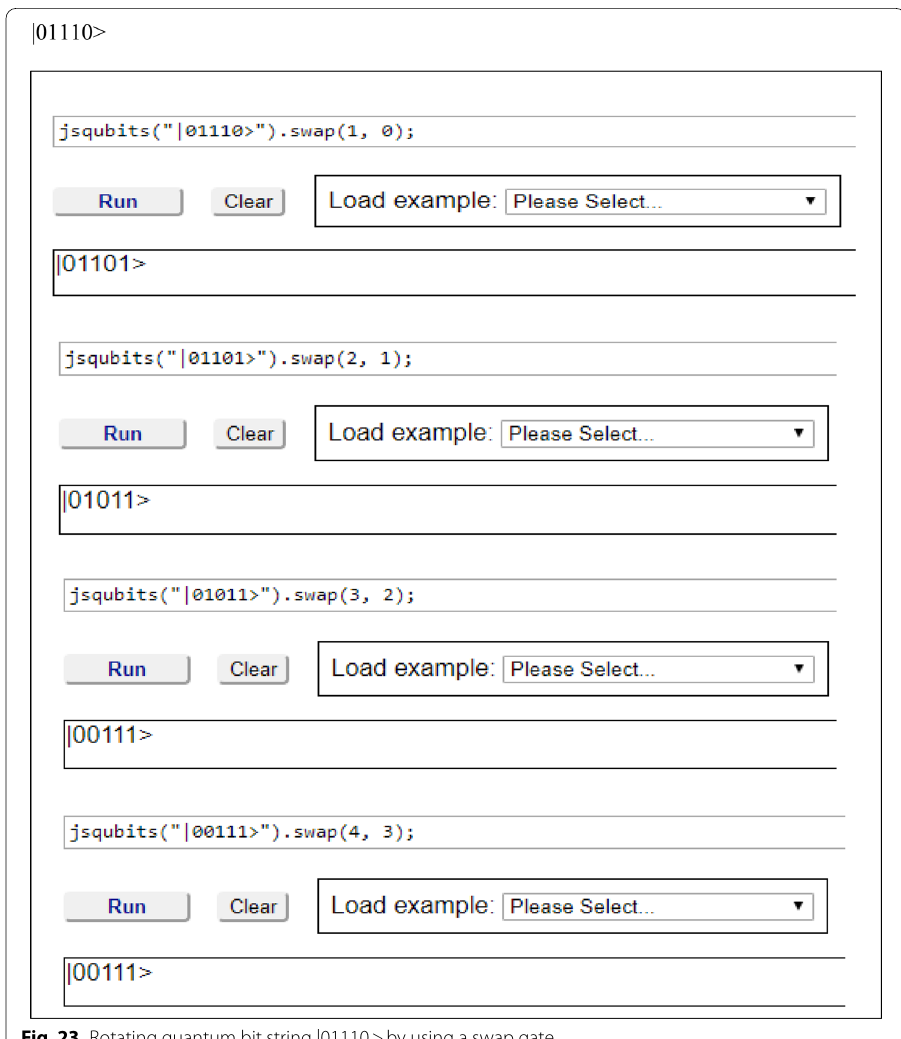
Fig. 23 Rotating quantum bit string |01110 > by using a swap